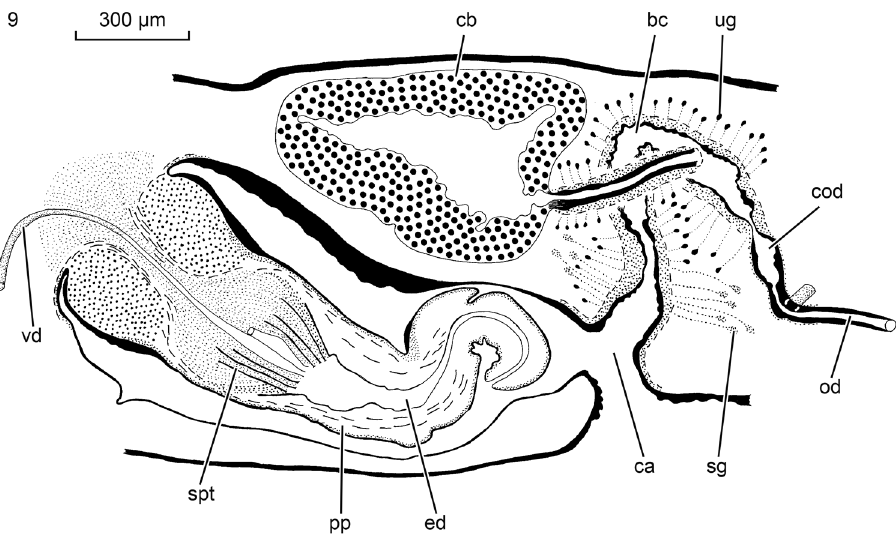
Figure 9. Obrimoposthia wandeli . NIBRIV0000813547, sagittal reconstruction of the copulatory ap- paratus; anterior to the